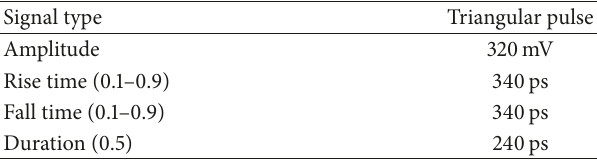
Table 3: Signal parameters at the pulse shaper